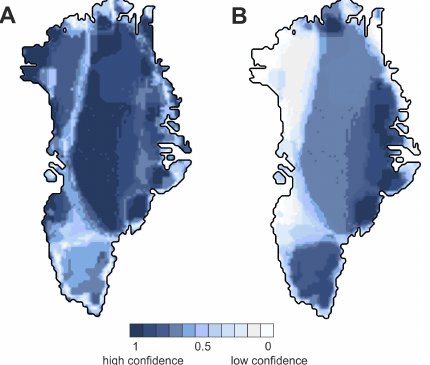
Figure 6. Measures of (a) inter-model and (b) overall confidence in Pliocene ice sheet simulations normalized to 0–1. See text for calculations.